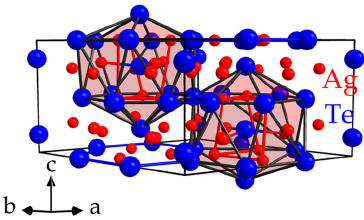
Figure 5. Representation of the crystal structure of stützite, which is composed of interpenetrating hexagonal tellurium antiprisms enclosing Te centered tricapped trigonal silver antiprisms (see main text). The silver and tellurium atoms shown in the representation correspond to those atomic sites with the largest site occupational factors.